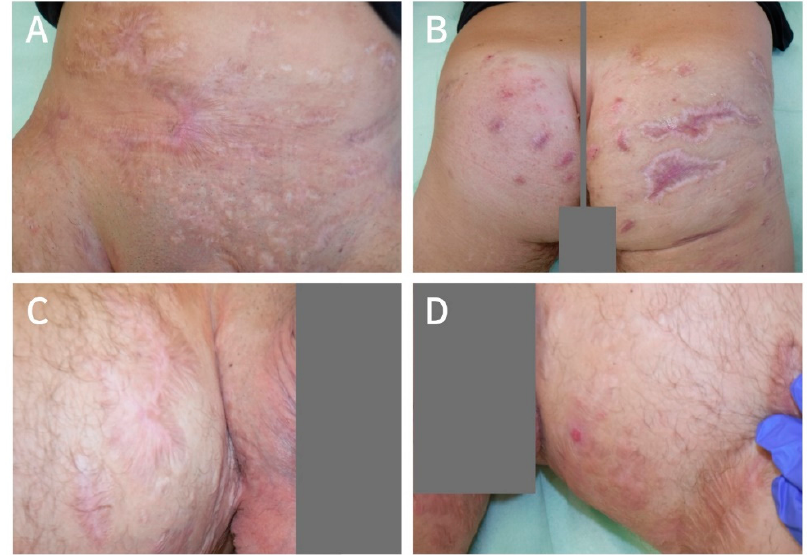
Figure 3. Manifestation of HS the mons pubis area and lower abdomen ( A ), buttocks ( B ), right thigh ( C ) and left thigh ( D ) after additional 25 months of regular LAight therapy (April 2020).